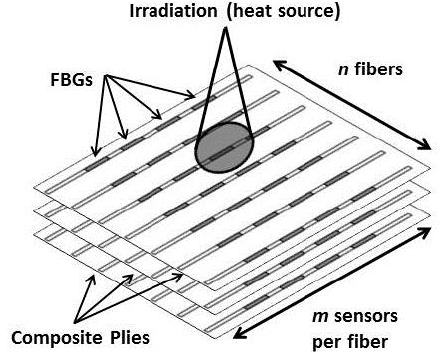
Figure 2. Multiple plies of composite with embedded n × m arrays of sensors on each layer.